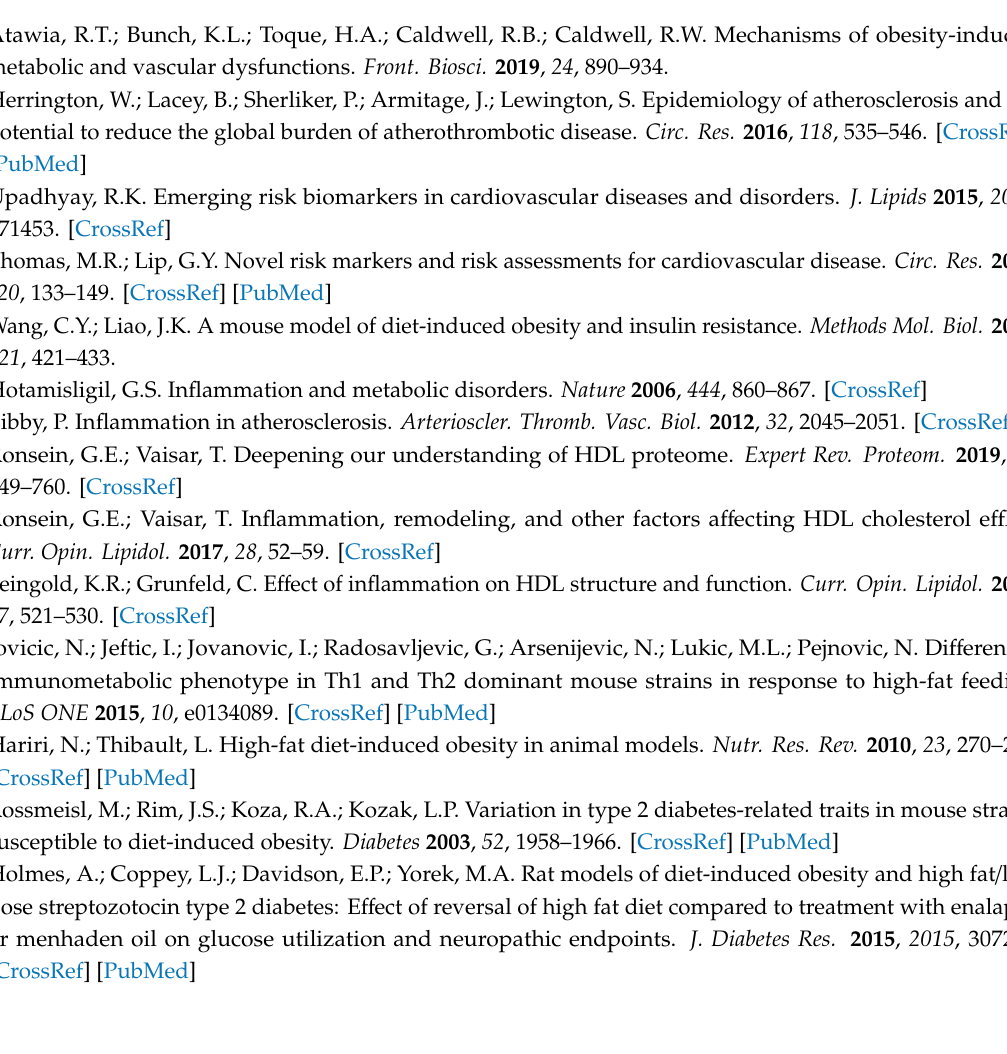
s1. Figure S1: Representative images of the isolated liver tissue and hematoxylin and eosin (H&E) stained liver sections from mice fed either a control diet or a high-fat diet for 4-weeks. The staining shows a lack of steatotic changes in the liver after four weeks of high-fat feeding. Figure S2: Representation of the protein-protein interaction networks of complement activation. Functional enrichment analysis of the proteins identified in the HDL proteome dynamics study revealed increased turnover rates of alternative and terminal complement activation pathways (denoted in red) upon high-fat feeding in wild type mice for four weeks. Figure S3: Gene expression analysis using RNA isolated from livers of mice fed either the control diet or the high-fat diet. At the end of the study, the livers from the mice were harvested and RNA was isolated. Complementary DNA (cDNA) was synthesized from the RNA and the quantitative real-time polymerase chain reaction (qRT-PCR) was performed. The relative expression of indicated genes was calculated using the Ct method. Statistical significance, ** indicates p < 0.01, n = 6–7 / group. Table S1: Primer sequences used for quantitative real-time polymerase chain reaction